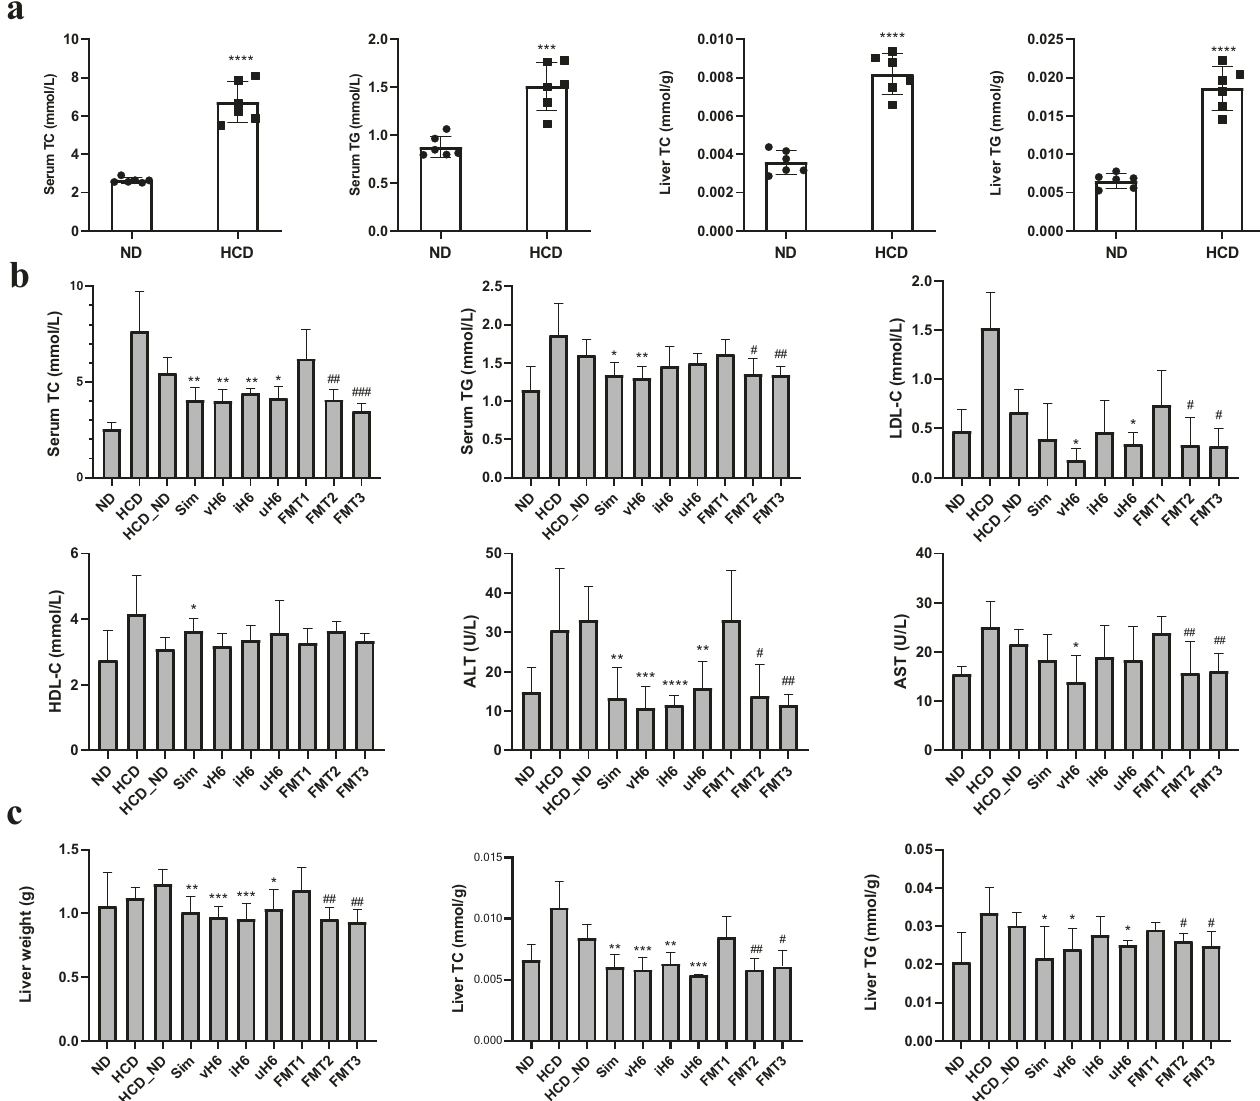
Fig. 1 Effects of v/i/uH6 and FMT on serum and liver physicochemical indices in mice. a Serum TC and TG and liver TC and TG levels in hypercholesterolemia model mice. Data are represented as the mean ± SEM ( n = 6). *** P < 0.001, **** P < 0.0001 vs. control ND. b Serum TC, TG, LDL-C, high-density lipoprotein cholesterol (HDL-C), ALT, and AST levels after 12 weeks. c Liver weight, TC, and TG levels. Data are represented as the mean ± SEM ( n = 8). * P < 0.05, ** P < 0.01, *** P < 0.001, **** P < 0.0001 vs. control HCD_ND; # P < 0.05, ## P < 0.01, ### P < 0.001 vs. control FMT1. HCD_ND refers to the group of hypercholesterolemia model mice; v/i/uH6 refers to viable (vH6), heat-inactivated (iH6), and ultrasonically-lysed (uH6) bacteria cells; FMT1/2/3 refers to using feces from HCD_ND, Sim, and vH6 groups,